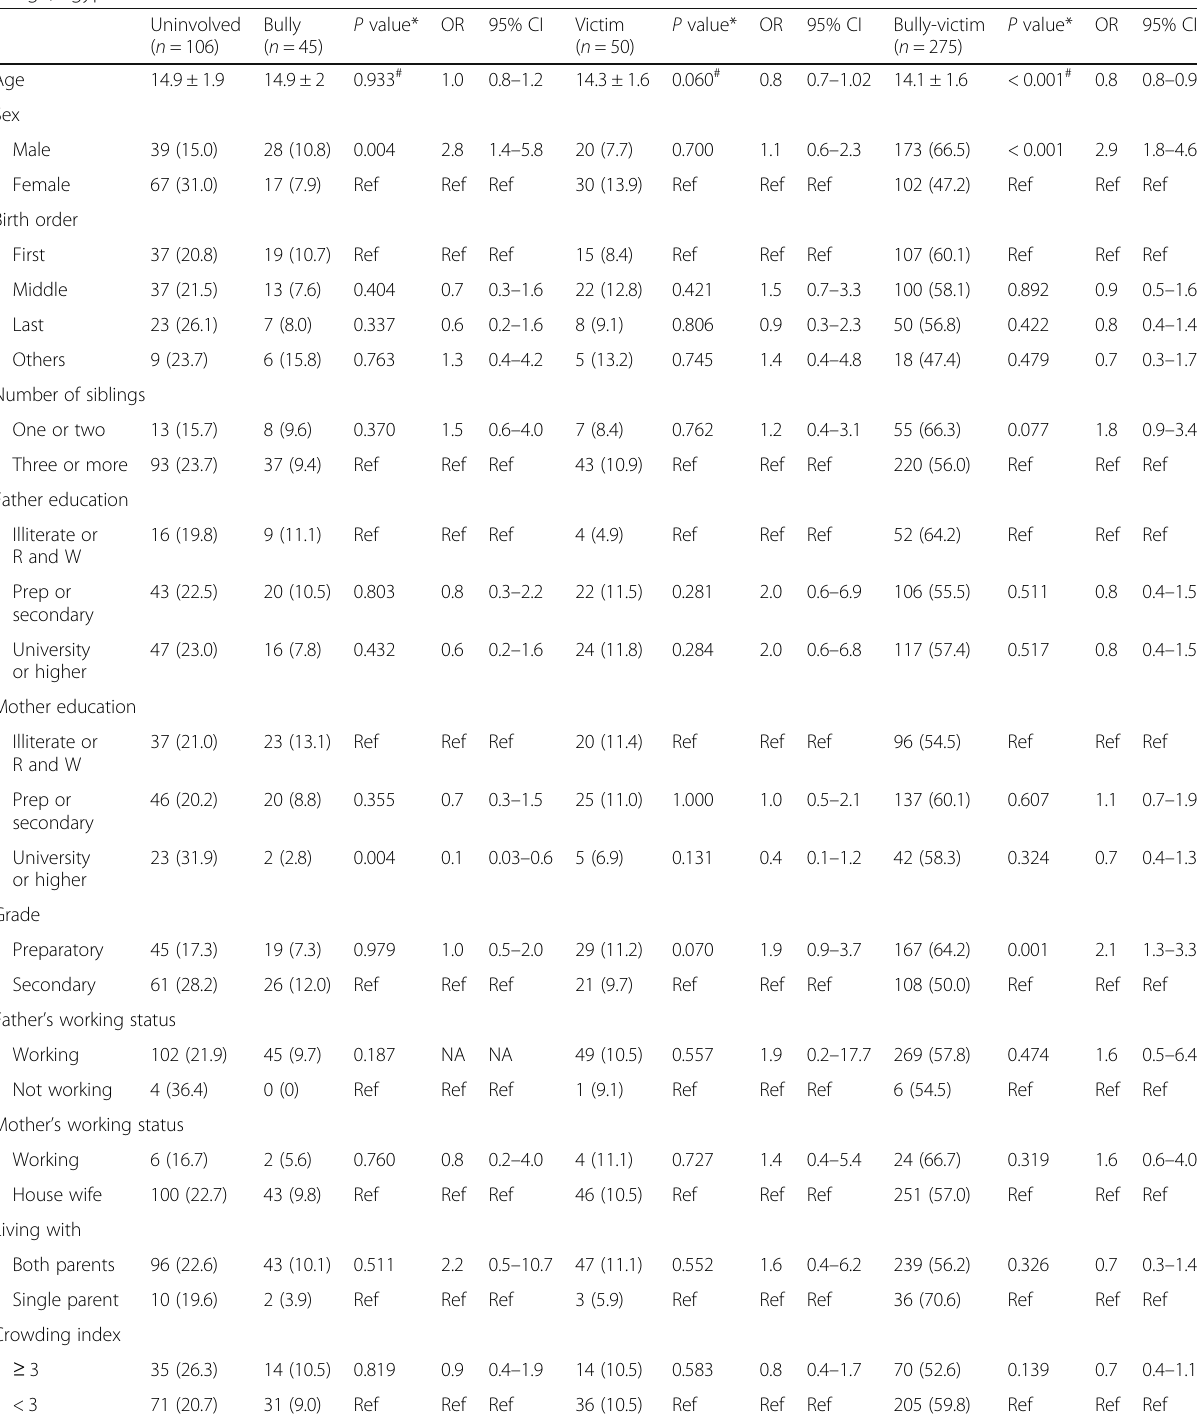
Table 1 Sociodemographic characteristics associated with bullying behavior among adolescent rural school students, Nikla rural village,